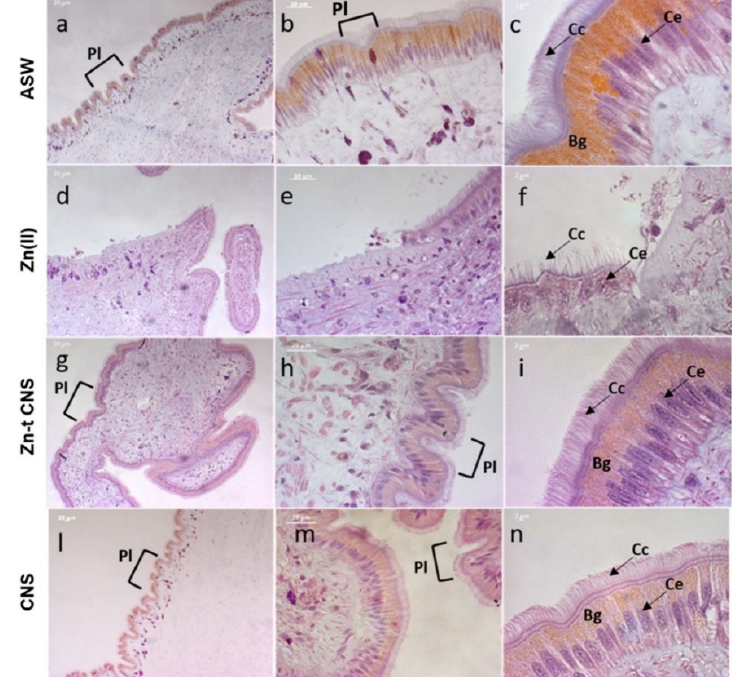
Figure 8. Light microscopy of mussels’ mantle edges stained with haematoxylin and eosin (H&E) of specimens exposed to the following experimental groups: ASW ( a , b , c , control); Zn(II) ( d , e , f , 10 mg L − 1 of ZnCl 2 in ASW); Zn-t CNS ( g , h , i , ZnCl 2 10 mg L − 1 contaminated ASW treated with CNS); CNS ( l , m , n , ASW treated with only CNS). Cc : Ciliated columnar cells; Ce : columnar epithelium; Bg : brown intracellular granules; Pl : plicae. Images obtained with a Zeiss Axiophot epifluorescent microscope with AxioCamMRc5.